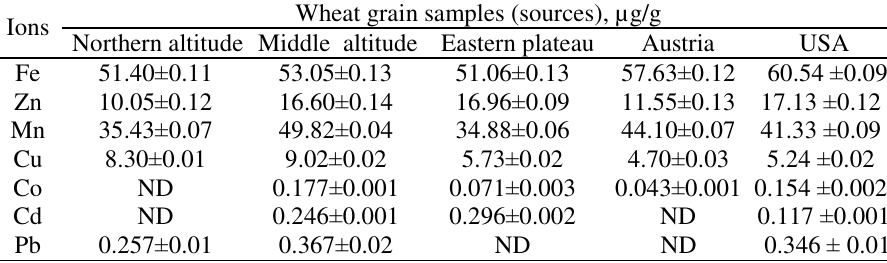
Table 1. Microelements content of the studied samples of wheat grain. Wheat grain samples (sources), µg/g